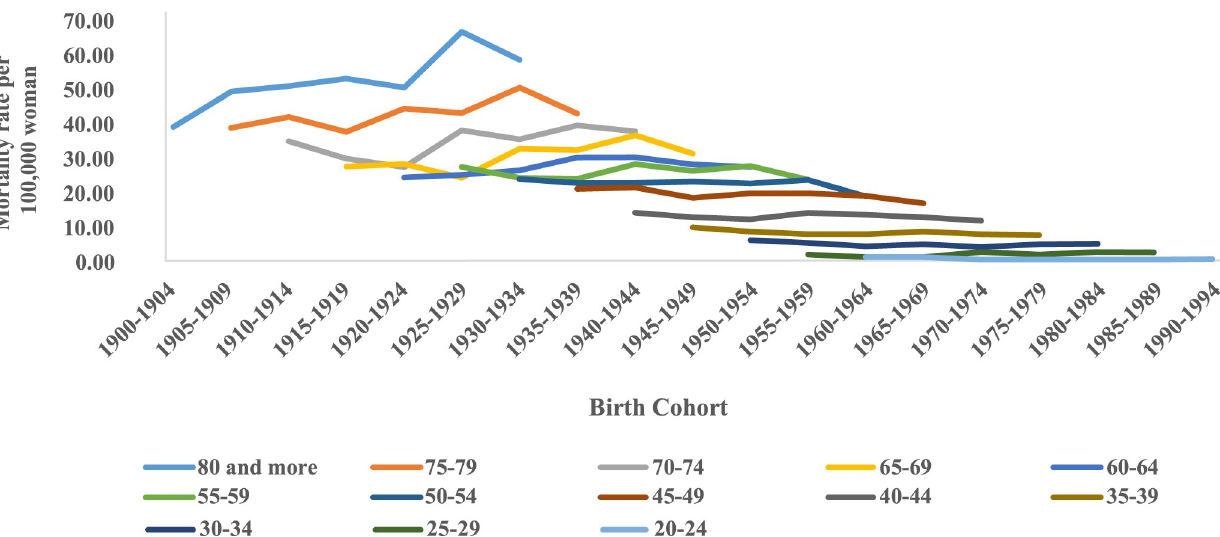
PLOS ONE | https://doi.org/10.1371/journal.pone.0226258 February 19,